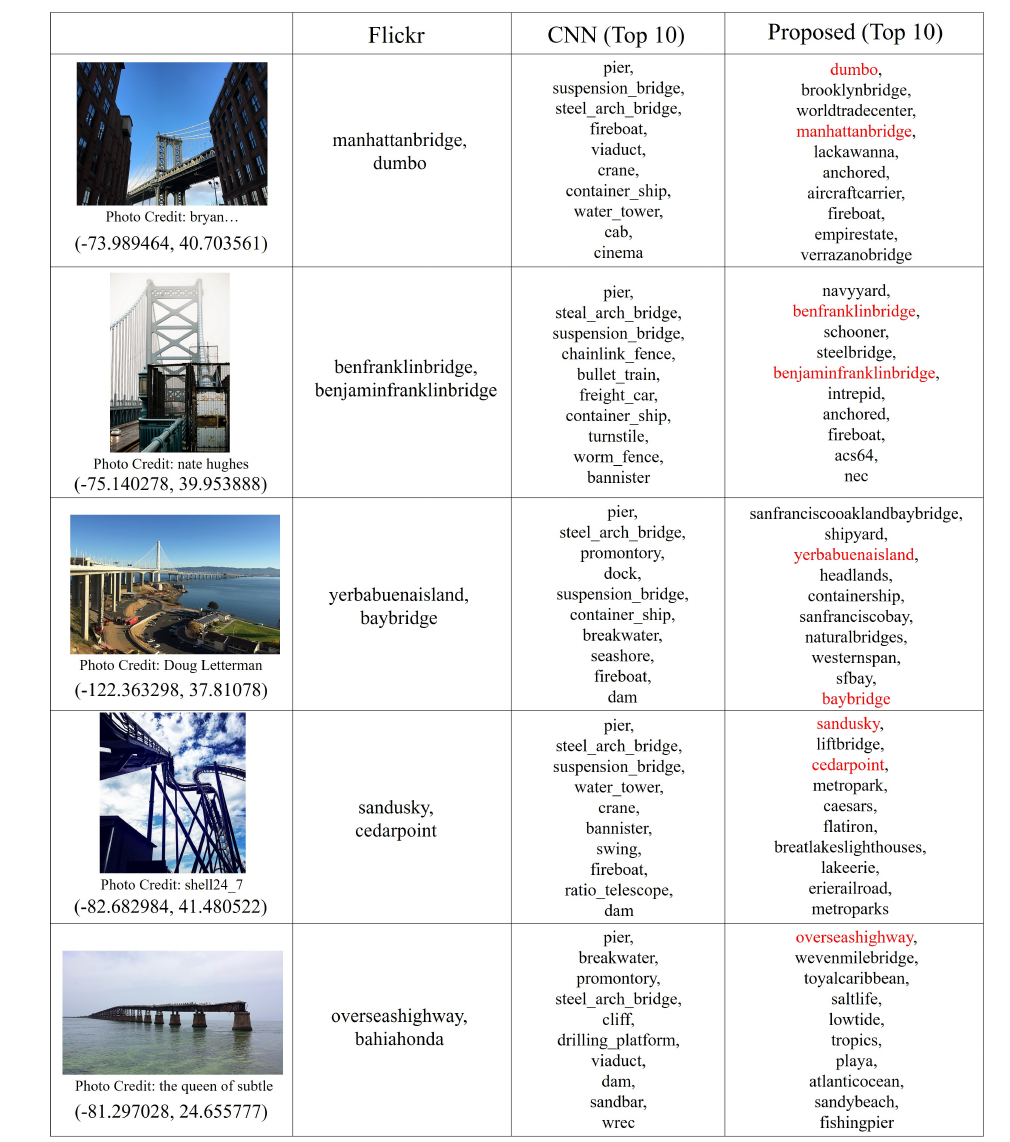
and recall of geo-aware image recognition. |I p |